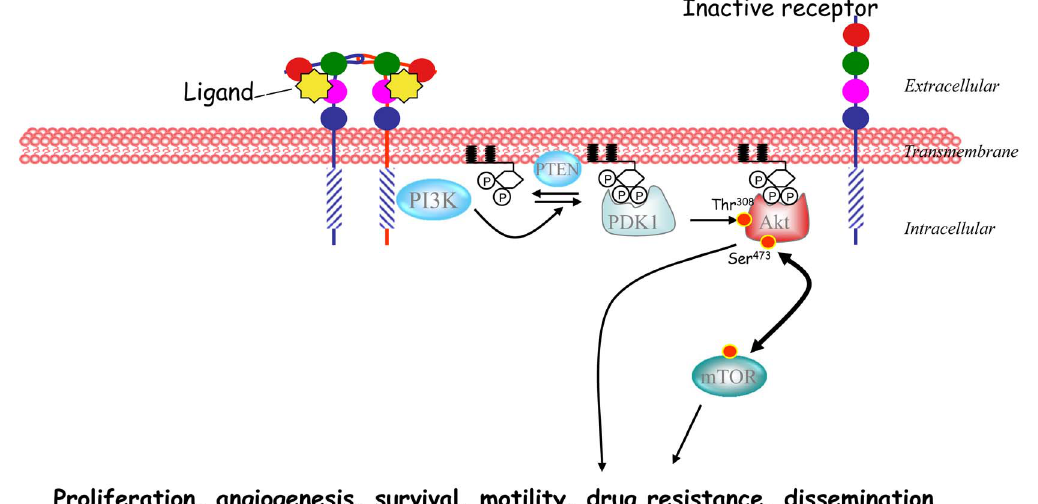
Figure 1. Schematic representation of the PI3K/mTOR pathway.